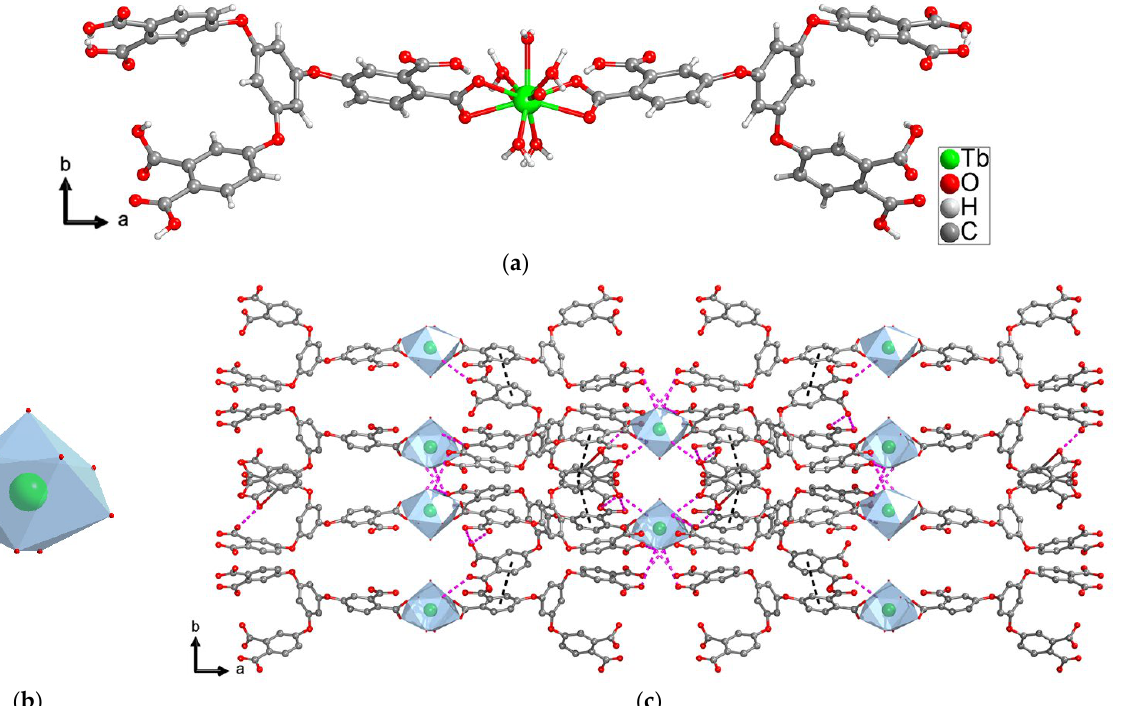
Figure 1. X-ray crystal structure of the compound 1 : ( a ) molecular structure (both positions of the disordered carboxylic proton are shown); ( b ) coordination polyhedron of Tb 3+ cation; ( c ) 3D supramolecular structure formed as a result of hydrogen bonding (purple dotted lines) and π - π stacking (black dotted lines).